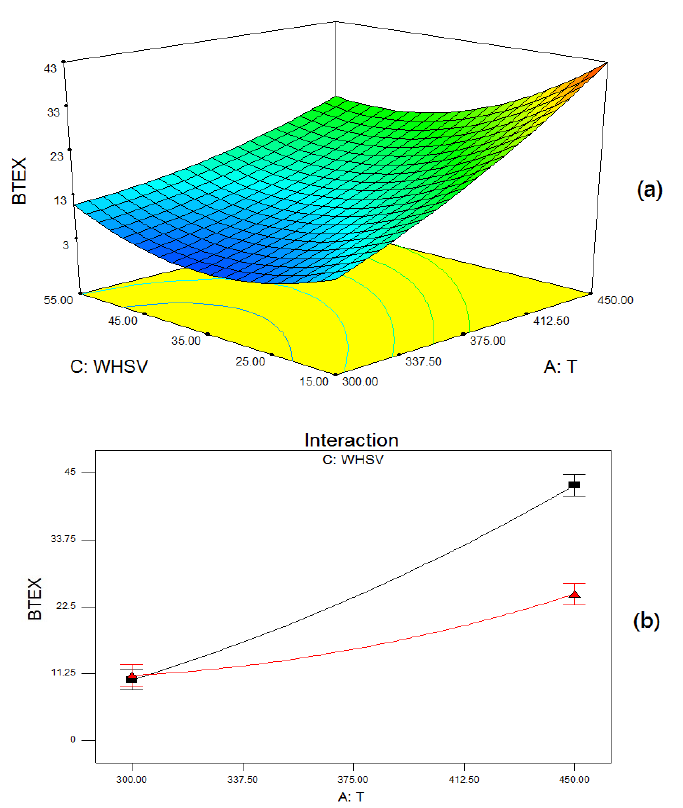
Figure 9. Interaction effect study between (C) WHSV and (A) temperature, under BETX (mol%) production. ( a ) 3D surface plot and ( b ) interaction plot.